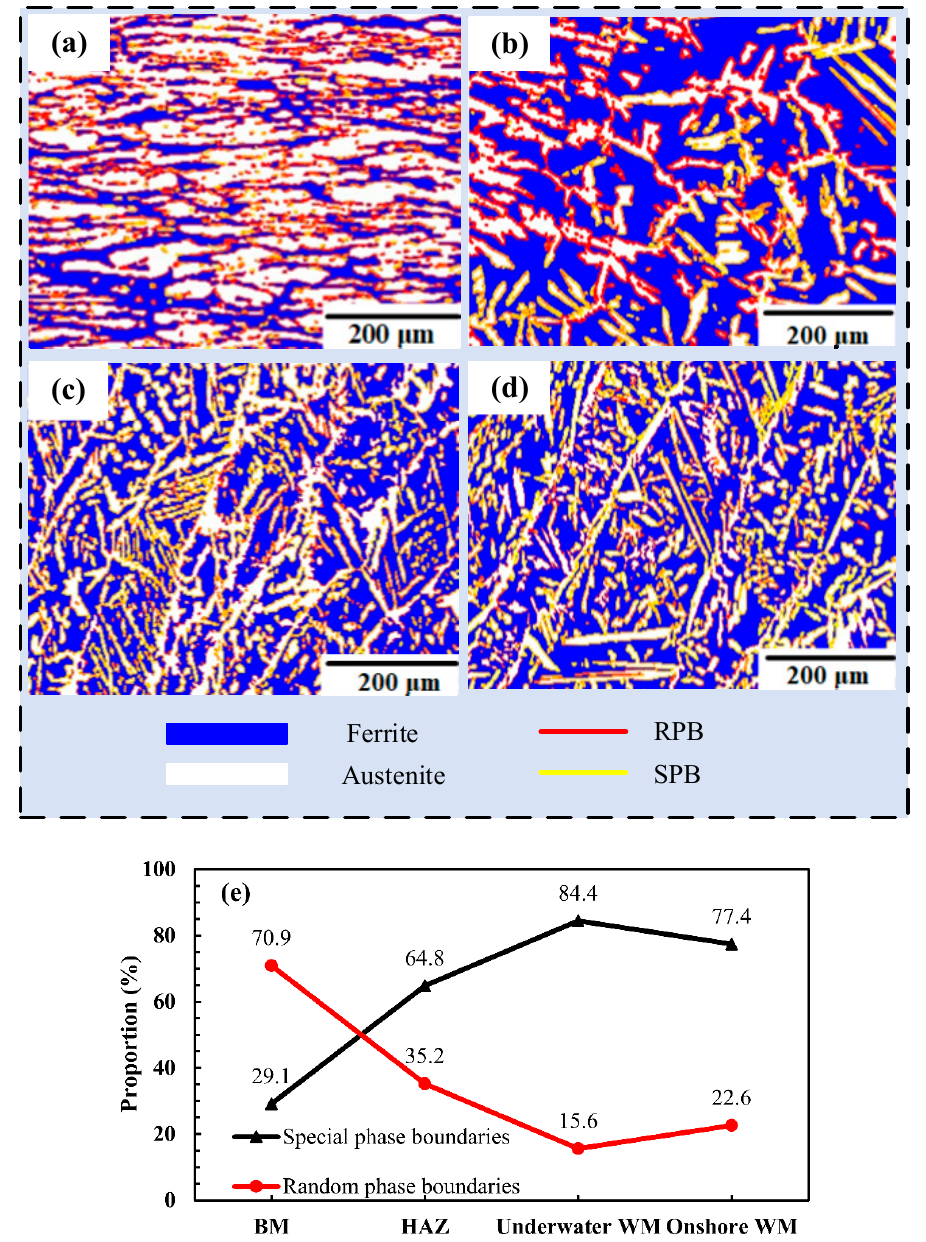
Figure 7. The orientations of the phase interfaces between ferrite and austenite: ( a ) BM, ( b ) HAZ, ( c ) underwater WM, ( d ) onshore WM and ( e ) The proportion of special phase boundaries (SPB) and random phase boundaries (RPB).